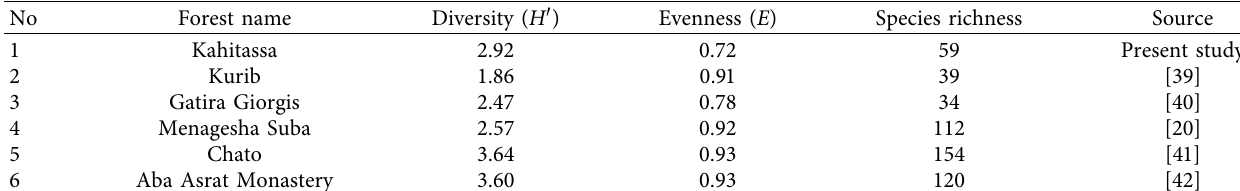
Figure 8: Percentage distributions of plant species against frequency class. Table 4: Phytogeographical comparison of Kahitassa forest with other forest